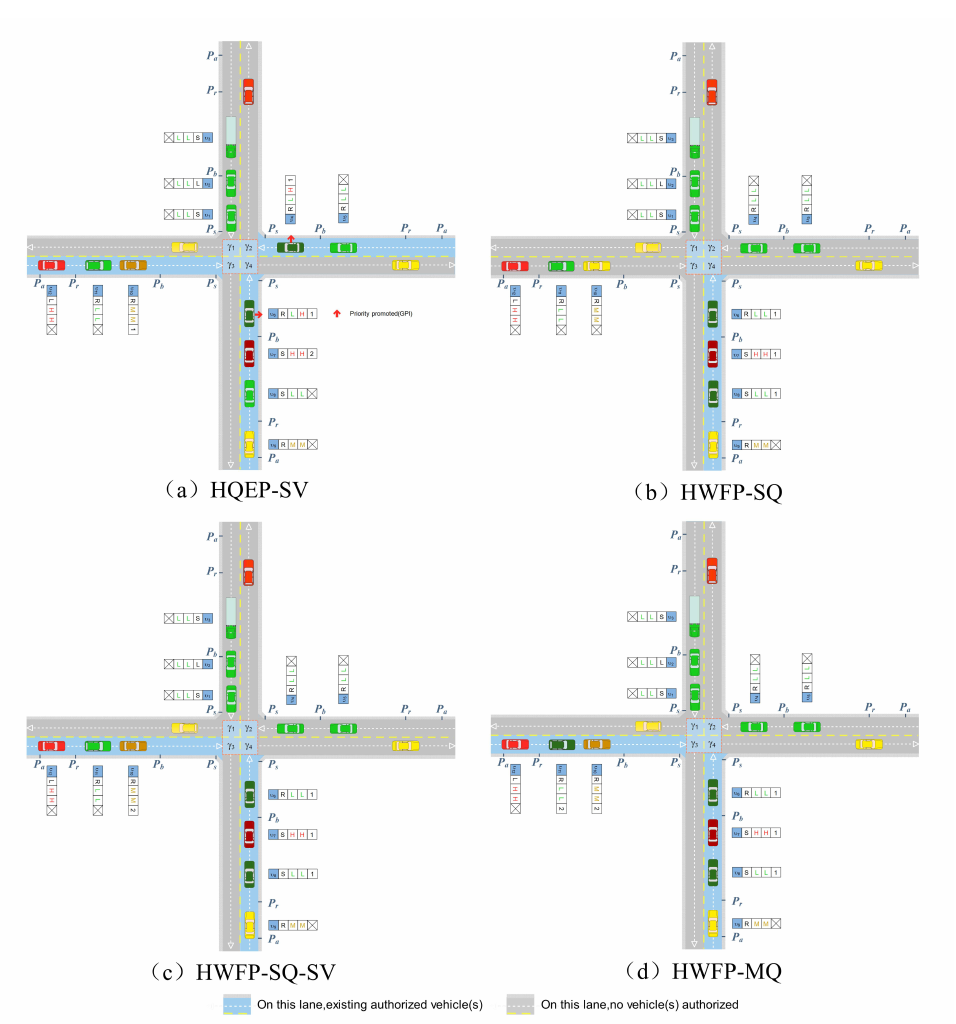
Figure 7. Traffic Situations with Four QoS-oriented Cooperation Policies. ( a ) HQEP-SV. ( b ) HWFP-SQ. ( c ) HWFP-SQ-SV. ( d )